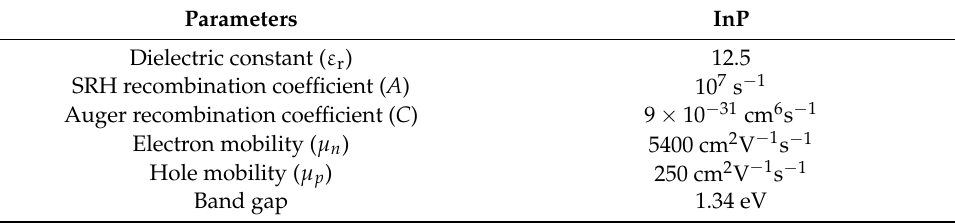
Table 1. The parameters used in the drift–diffusion model